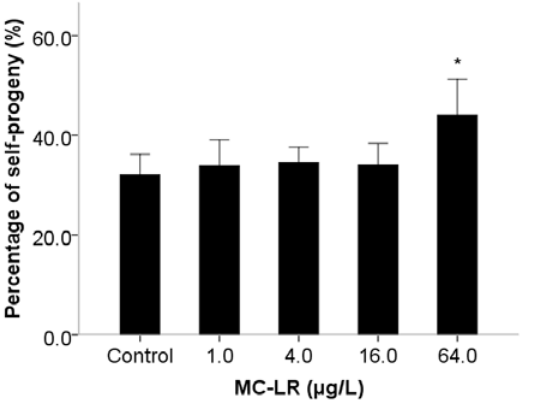
Figure 4. Effects of MC-LR exposure on sperm migration. The number of abnormal sperm migration worms and total worms were counted. Bars represent means ± SEM. * p < 0.05 vs . the control group.